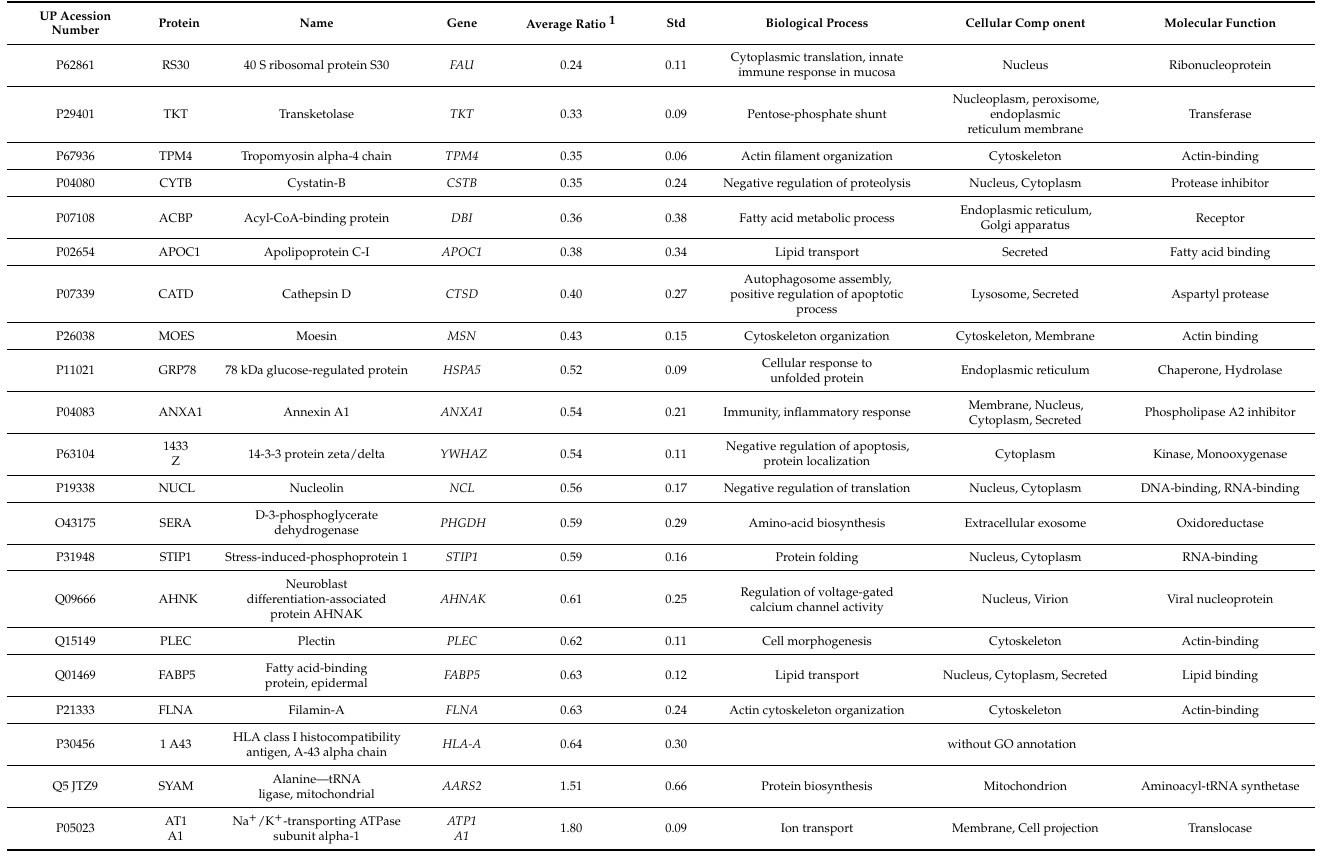
Table 1. List of differentially deregulated targets between irradiated (5 × 2 Gy) and non-irradiated (0 Gy) macrophages, which exhibit the same trend in at least 3 donors. The main data from the three Gene Ontology categories–biological processes (BP), molecular function (MF) and cellular component (CC) associated with these targets are indicated.